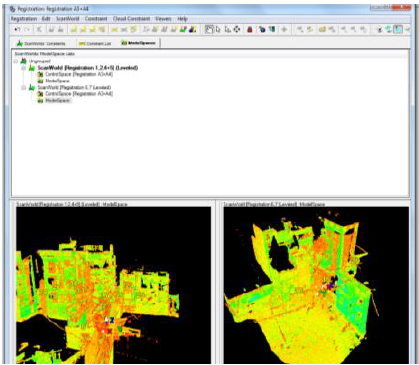
Figure 5. 3D model by Autodesk Revit.